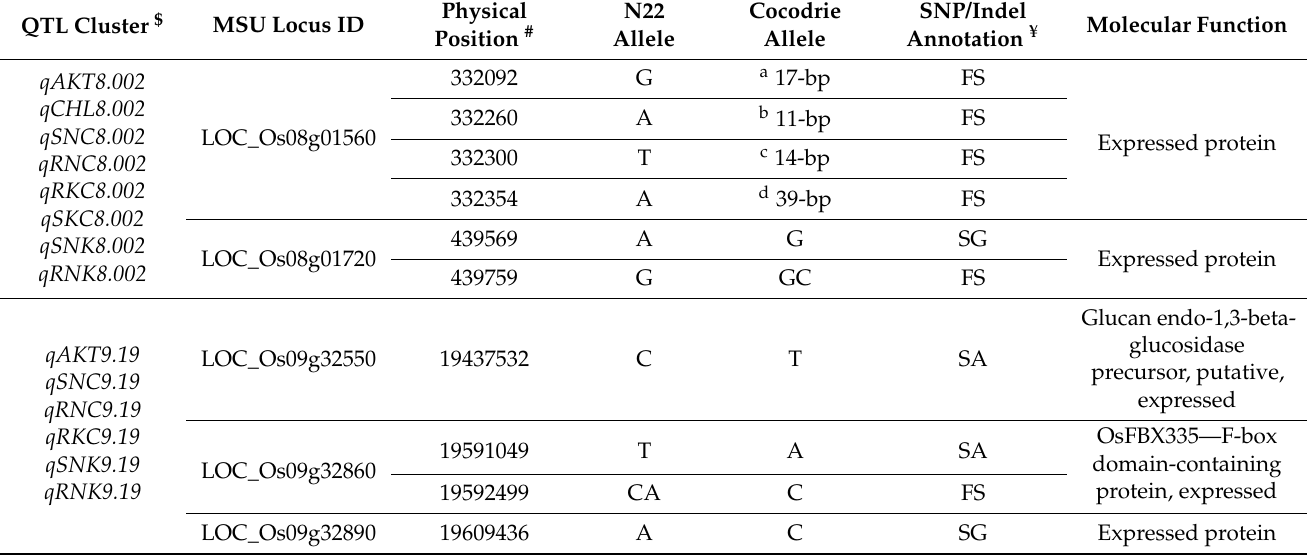
Table 6. Polymorphic SNPs and indels (high-impact) in the genomic region of three selected QTLs between Cocodrie and